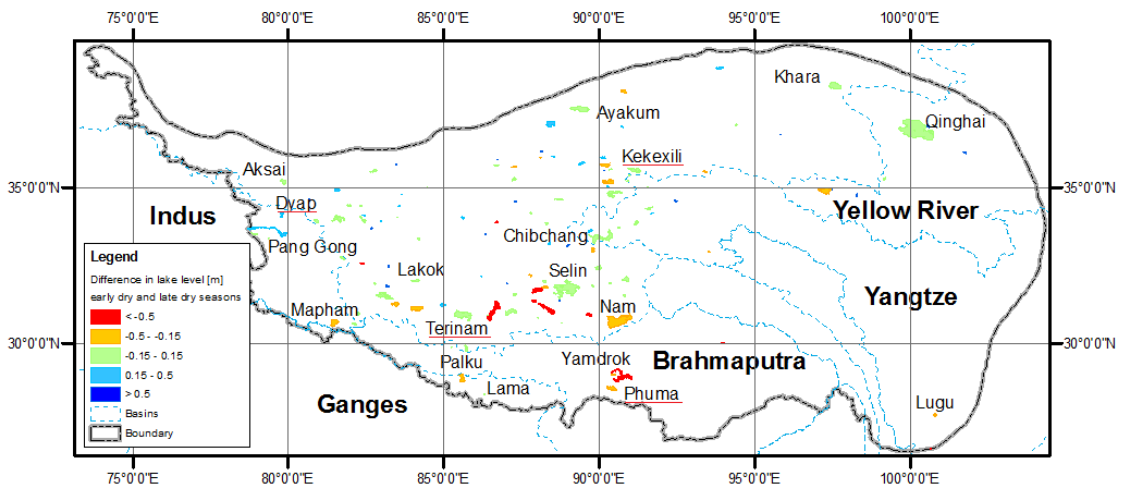
Figure 4b. Average lake level differences during the dry season on the Tibetan plateau between 2003 and 2009